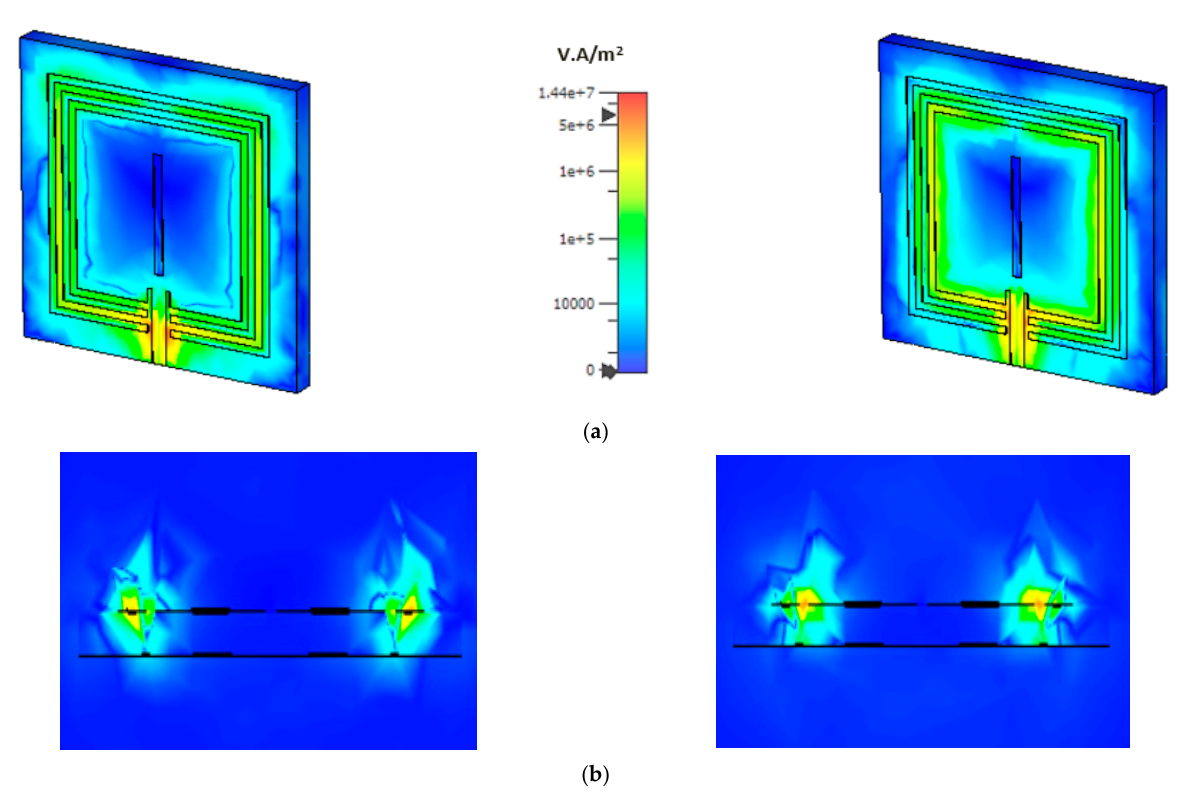
Figure 8. ( a ) Aerial view and ( b ) lateral view of power flow distribution on the left side at 3.56 GHz and right side at 4.14 GHz.